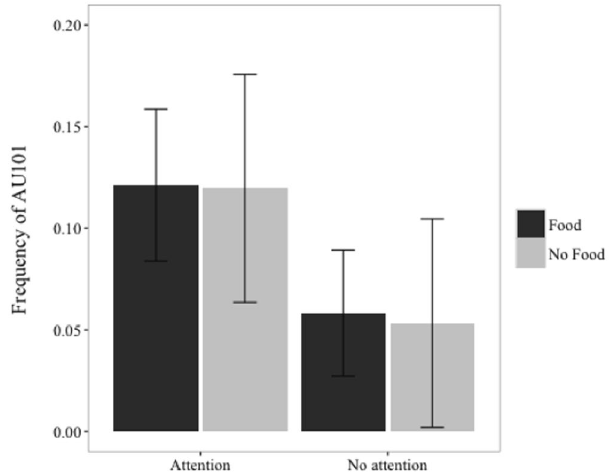
Figure 1. Mean rate ( ± 1 SD) of facial movement AU101 (Inner eye brow raise) as a function of